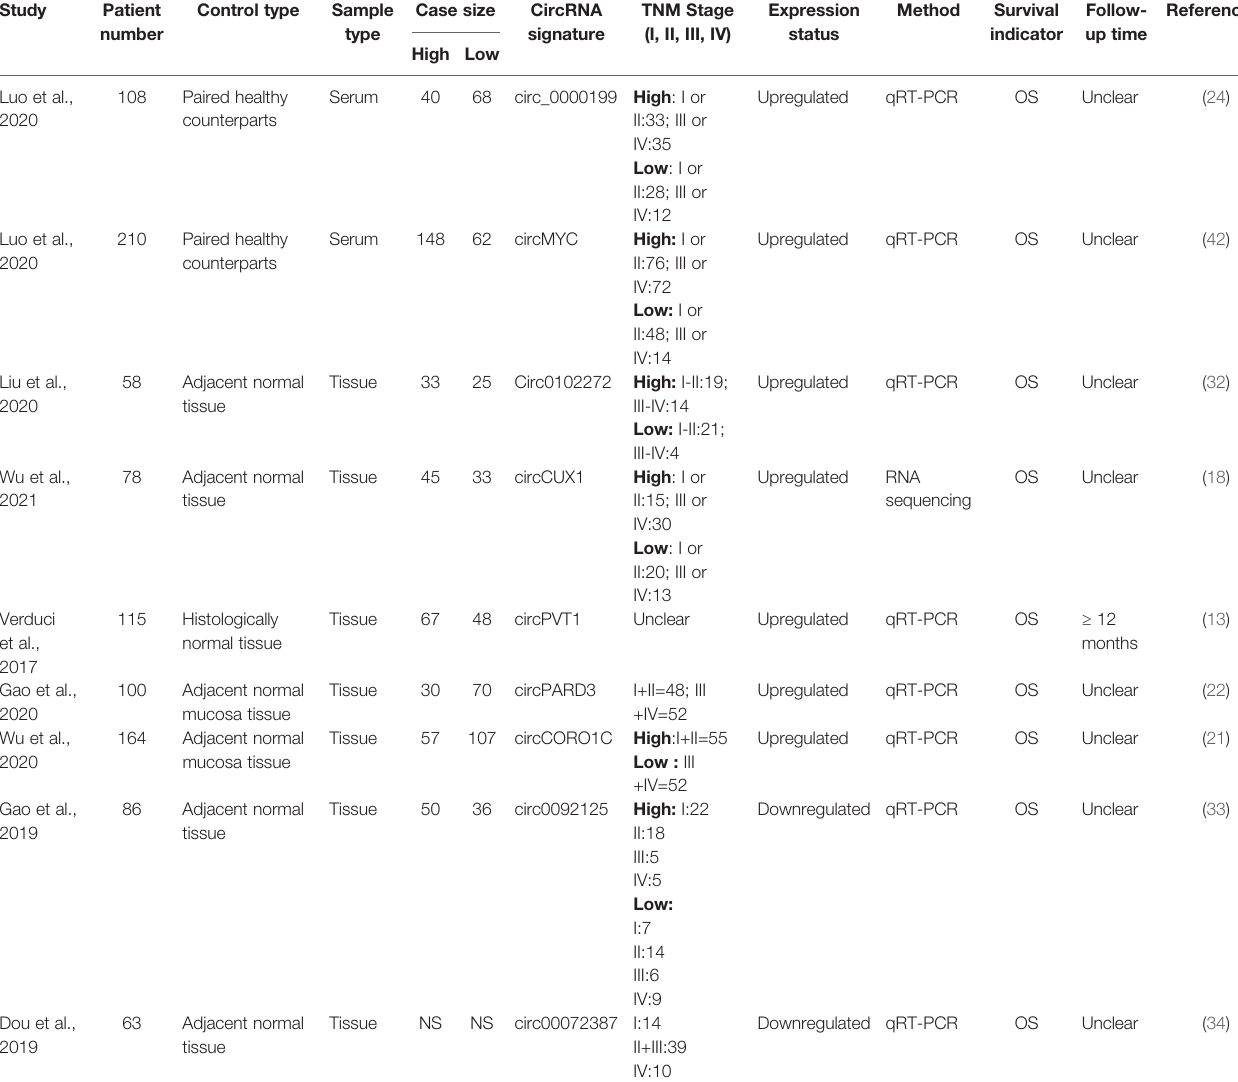
TABLE 2 | Characteristics of the included